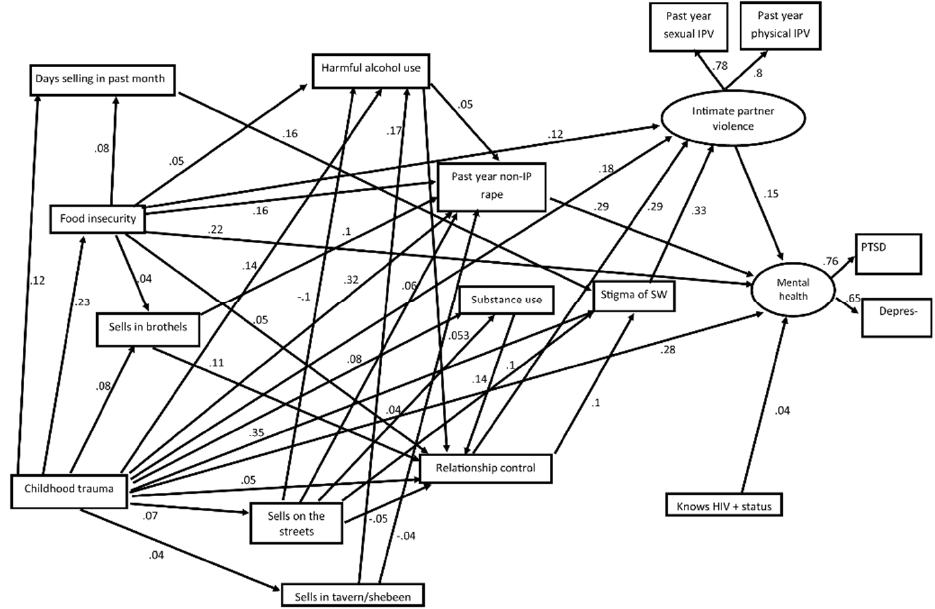
Figure 2. Structural equation model showing direct and mediated relationships to mental ill-health amongst female sex workers in South Africa.